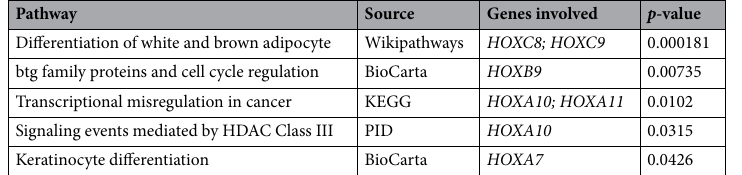
Table 2. HOX genes involved in the over represented pathways using integrated molecular pathway level analysis (ImPaLa) tool.